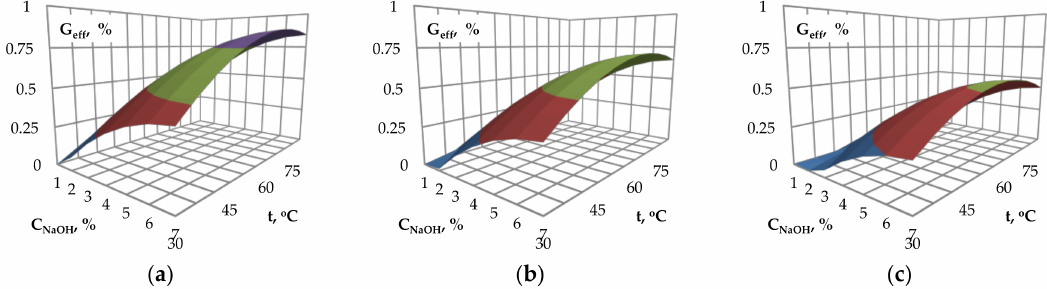
Figure 1. Influence of the catalyst concentration and the temperature on the glucose efficiency for the pre-treatment time of 7 h: ( a ) Granulation 0.25 mm; ( b ) Granulation 2 mm; ( c ) Granulation 4